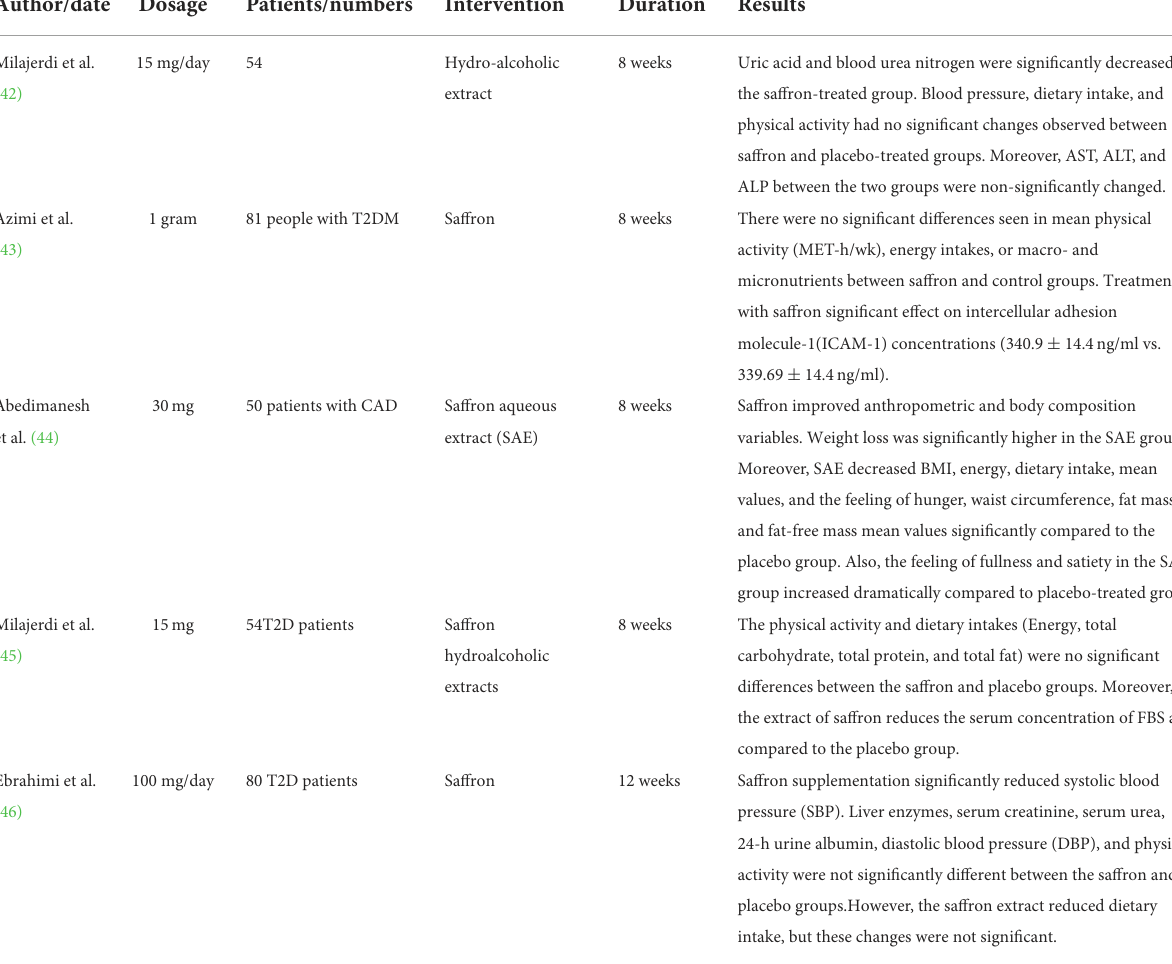
TABLE 2 Summary of effect estimates of C. sativus (saffron) for dietary